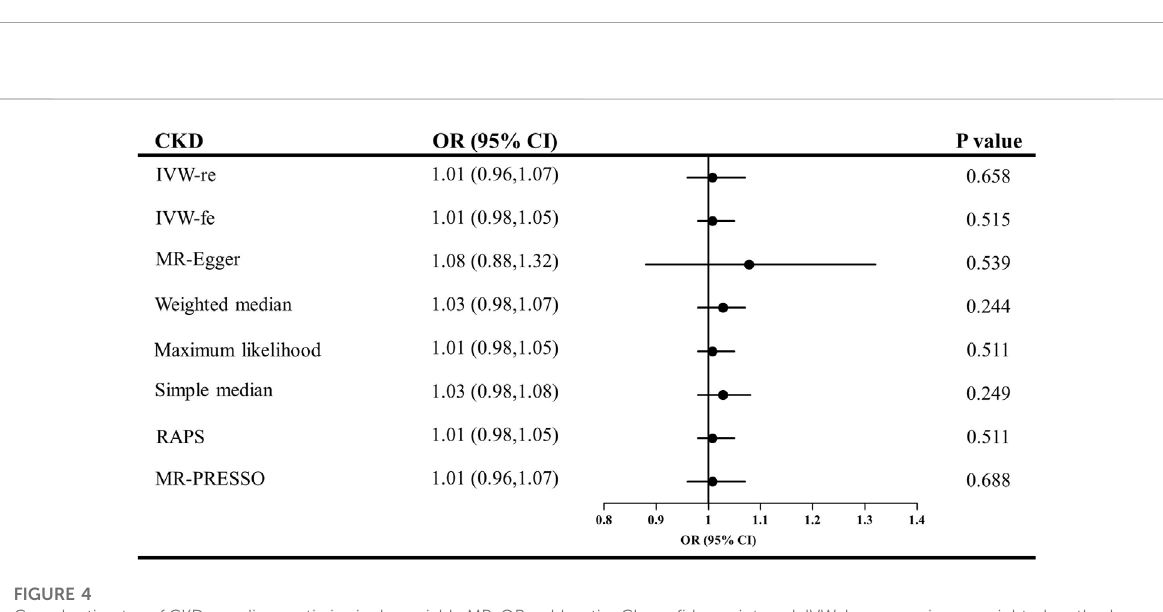
FIGURE 3 Causal estimates of adiponectin on eGFR in single-variable MR. Red line, signi fi cant; Black line, not signi fi cant; CI, con fi dence interval; eGFR, estimated glomerular fi ltration rate; IVW, Inverse variance weighted method; RAPS, robust adjusted pro fi le score; MR, Mendelian randomization; PRESSO, pleiotropy residual sum and outlier.